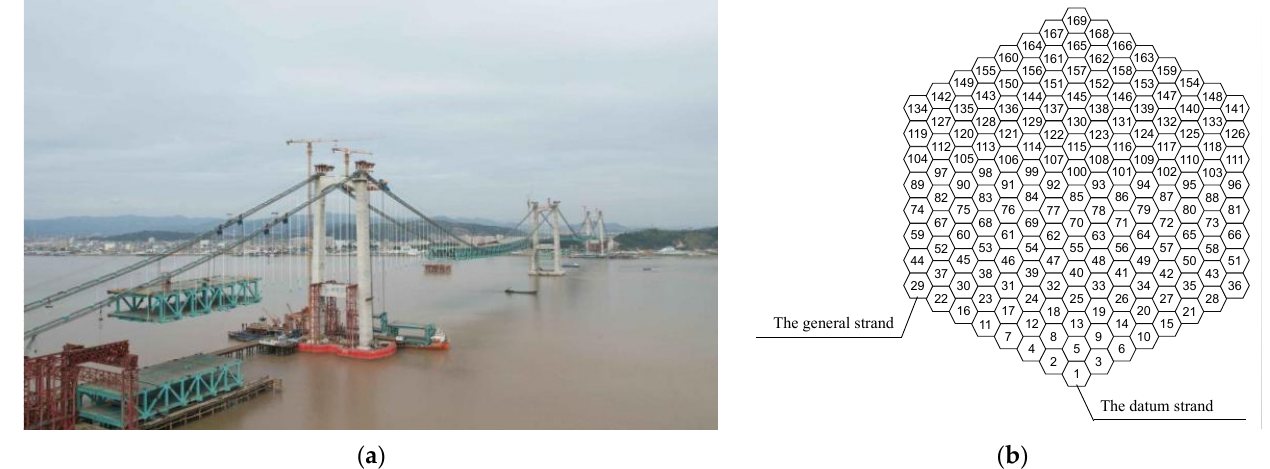
Figure 17. The Oujiang Beikou Bridge: ( a ) a photo of Oujiang Beikou bridge under construction; ( b ) an image of the cross section of the main suspension cables.